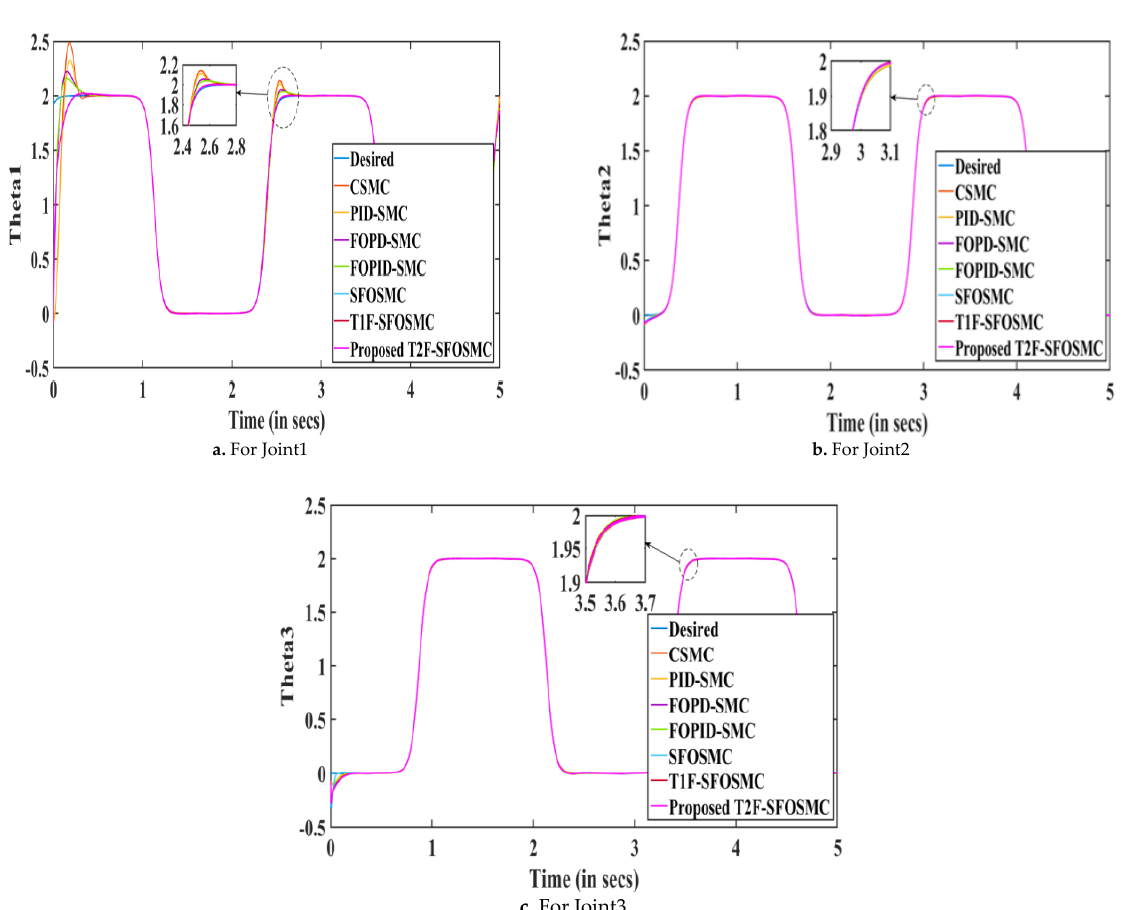
Figure 9. Trajectory tracking of the 3DOF surgical manipulator for Joint1, Joint2 and Joint3.